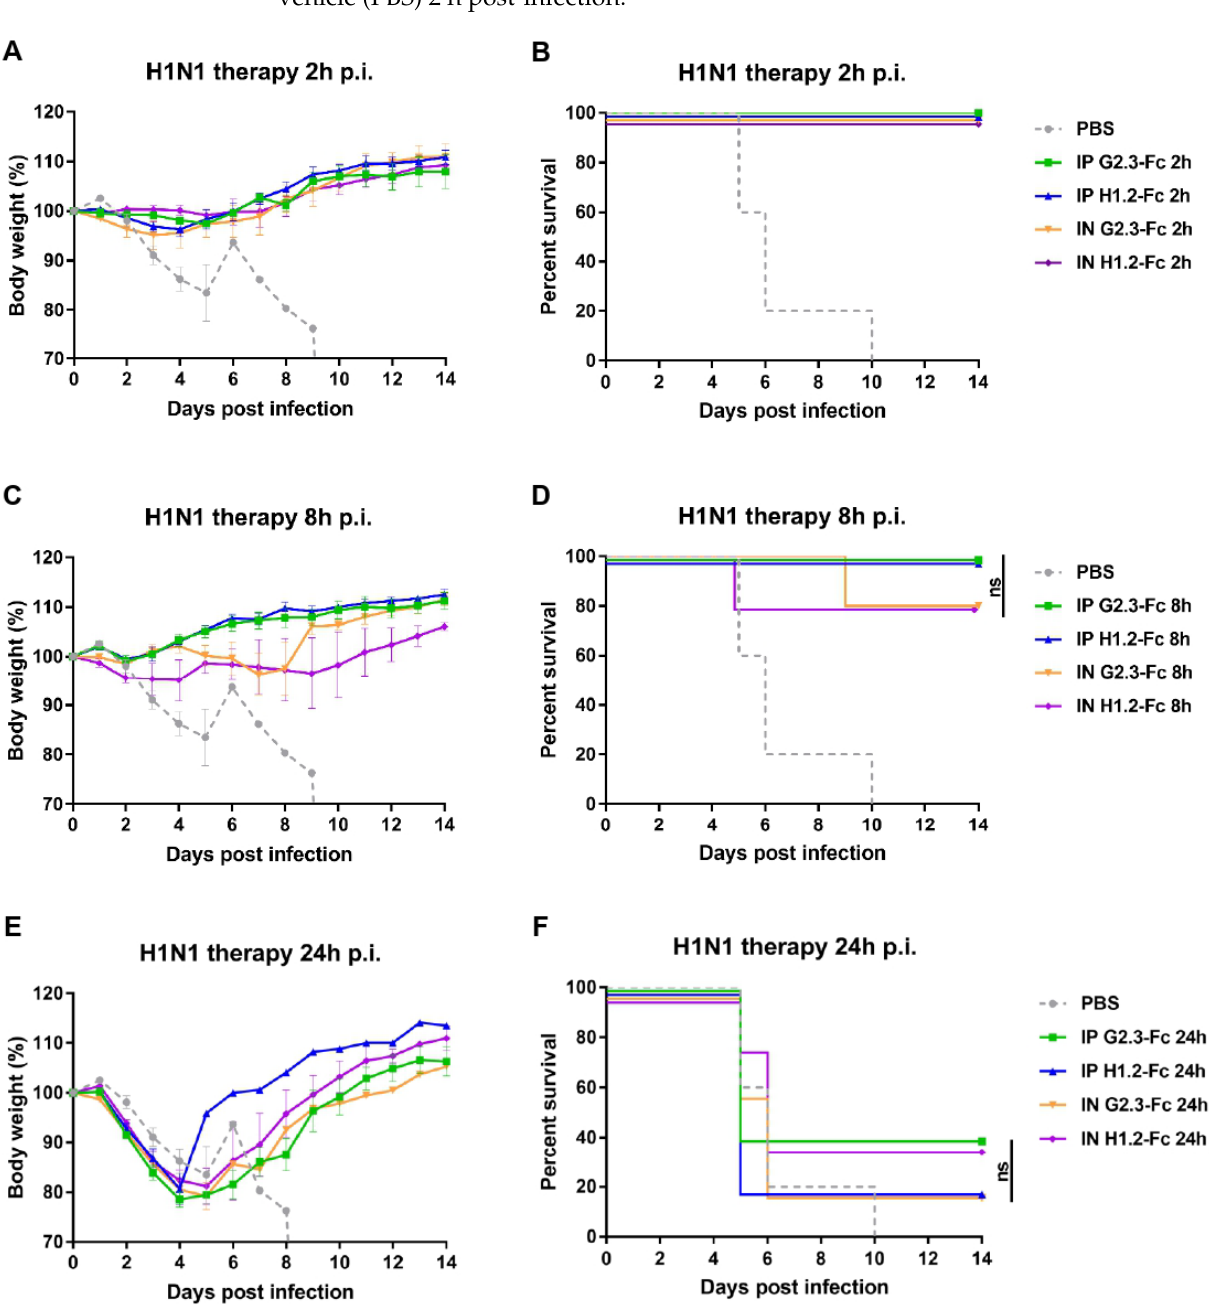
Figure 5. Therapeutic efficacy of VHH-Fc against H1N1 IAV in BALB/c mice. Body weights and survival curves of mice (n = 5 per group) treated with G2.3-Fc or H1.2-Fc with a dose of 10 mg/kg in case of i.p. injection or 2 mg/kg when delivered via the i.n. route. VHH-Fc were administered 2 h ( A , B ), 8 h ( C , D ), or 24 h ( E , F ) after the infection with 5 LD 50 of influenza CA/09(H1N1)ma virus. As a negative control, a vehicle (PBS) was administered 2 h after the infection via the i.n. route. Body weight curves represent mean value ± SEM. ns—the difference between groups is non-significant.